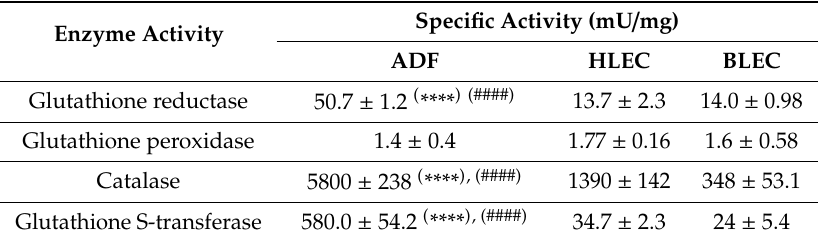
Table 2. Levels of enzymatic activities involved in antioxidant defense. Enzyme